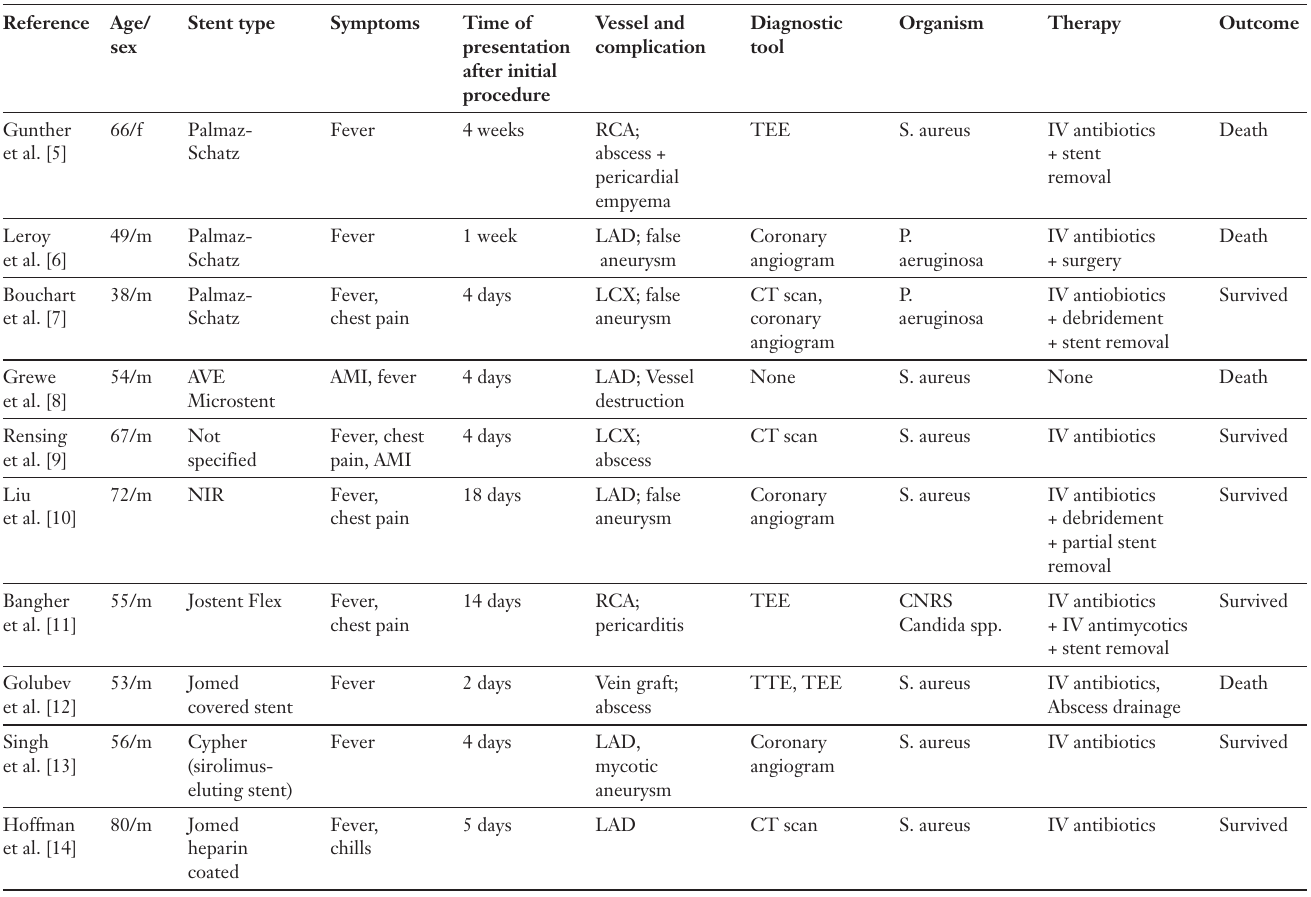
Published case reports of coronary stent